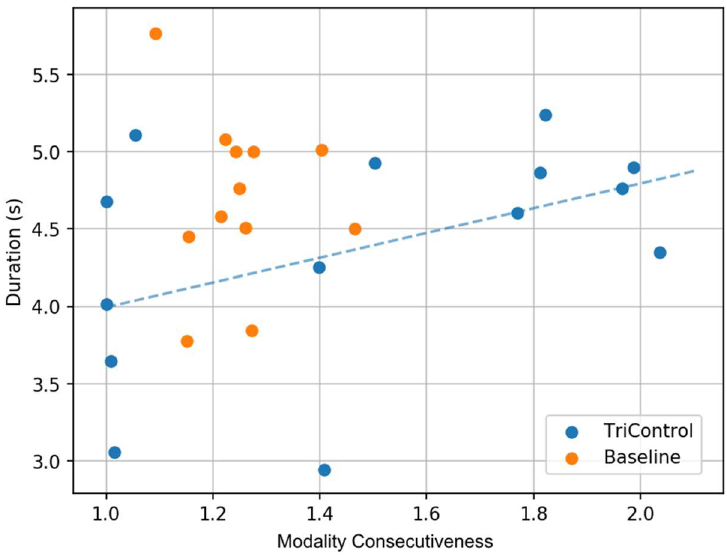
Figure 10. Command duration by modality consecutiveness for Baseline and TriControl second half uncorrected.